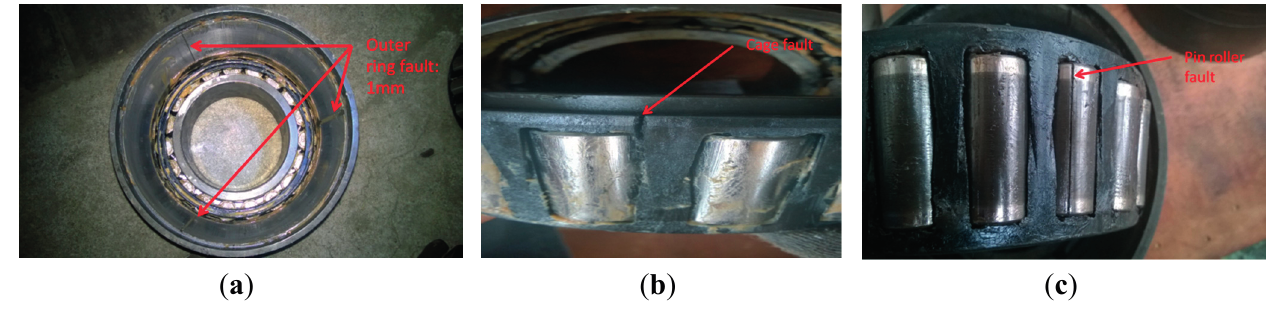
Figure 2. Railway axle bearing test-rig.